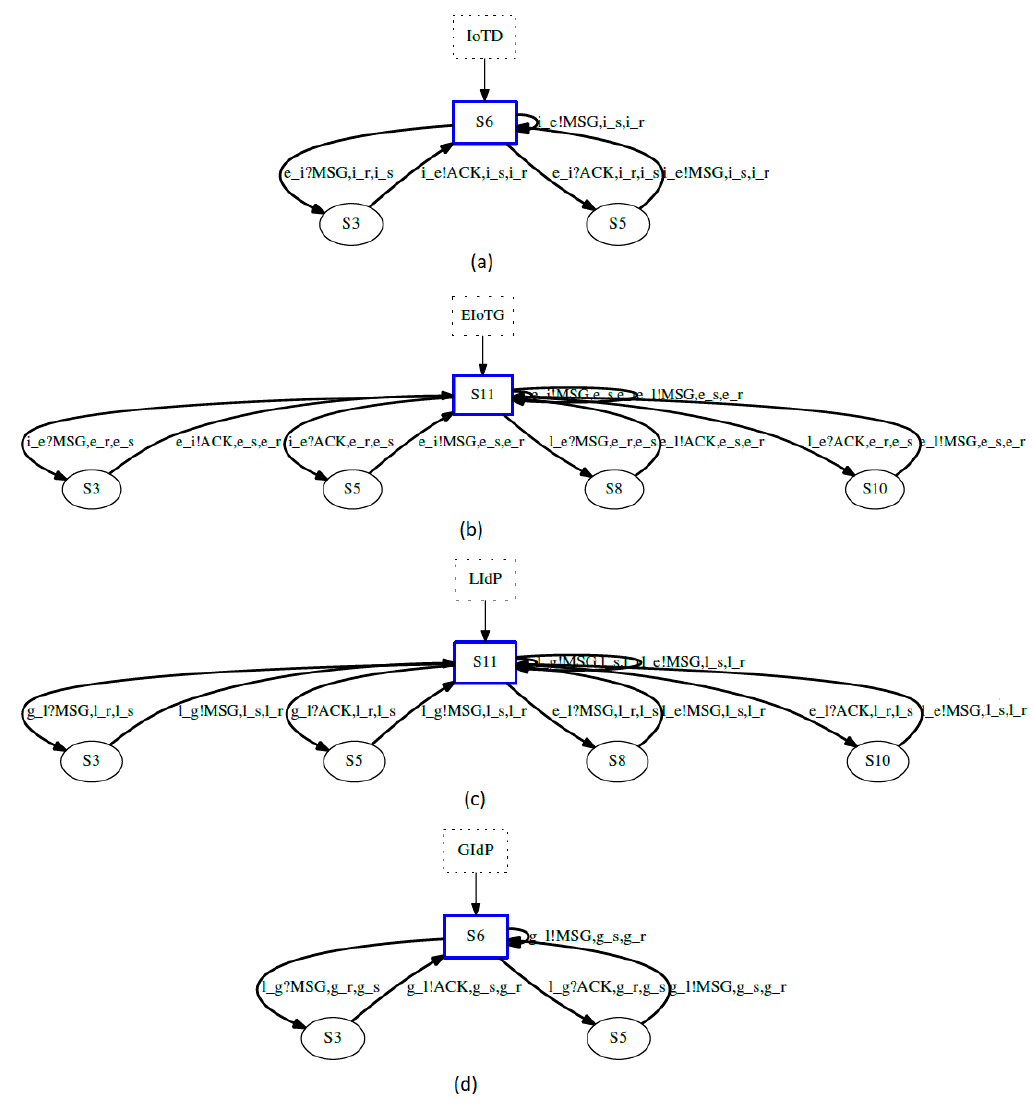
Figure 20. SPIN generated automata views for communication senarios of different components ( a ) IoTD ( b ) EIoTG ( c ) LIdP and ( d ) GIdP.